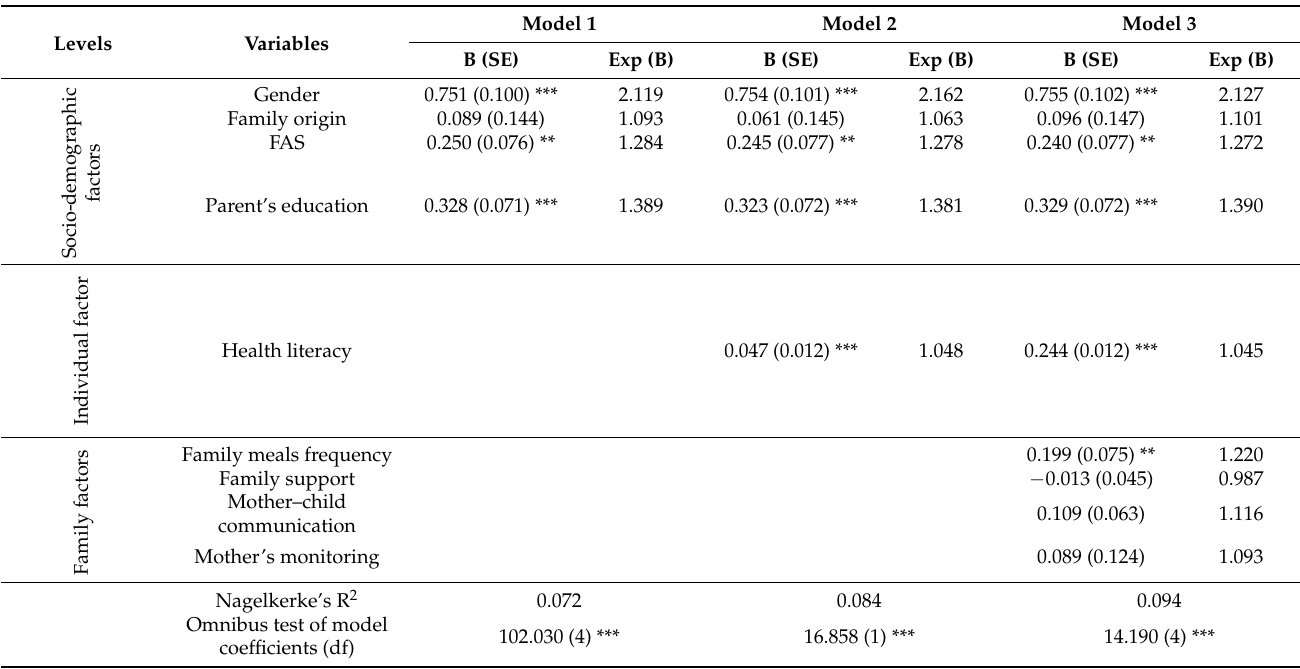
Table 4. Results of multiple binary logistic regression models predicting vegetable